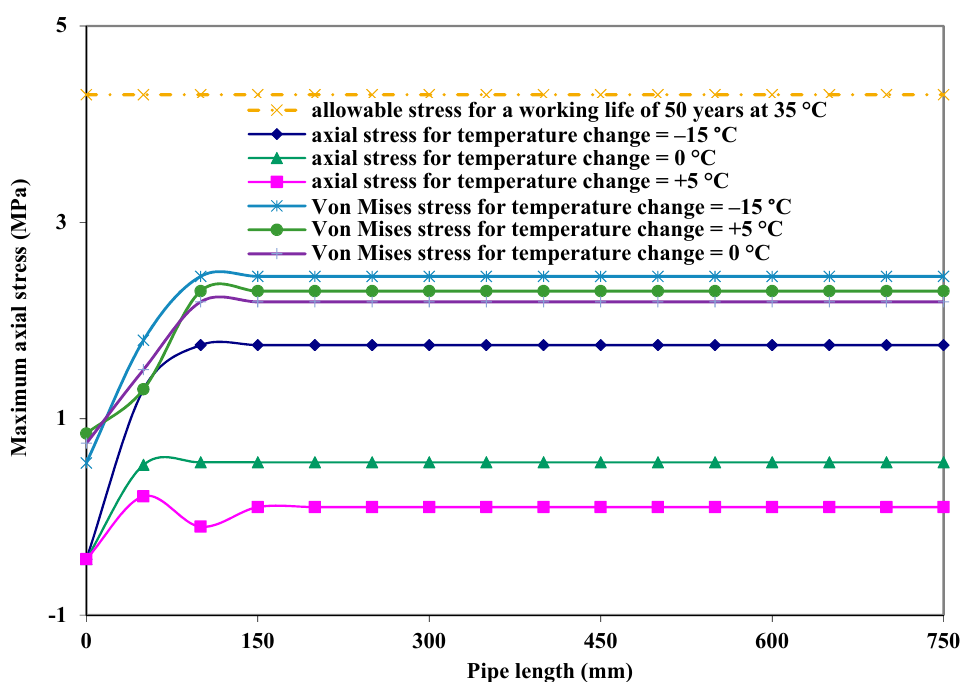
Figure 5. Maximum axial and Von Mises stress variations along the socket length (the simultaneous effect of soil load, internal pressure, vehicle wheel load and temperature variations).